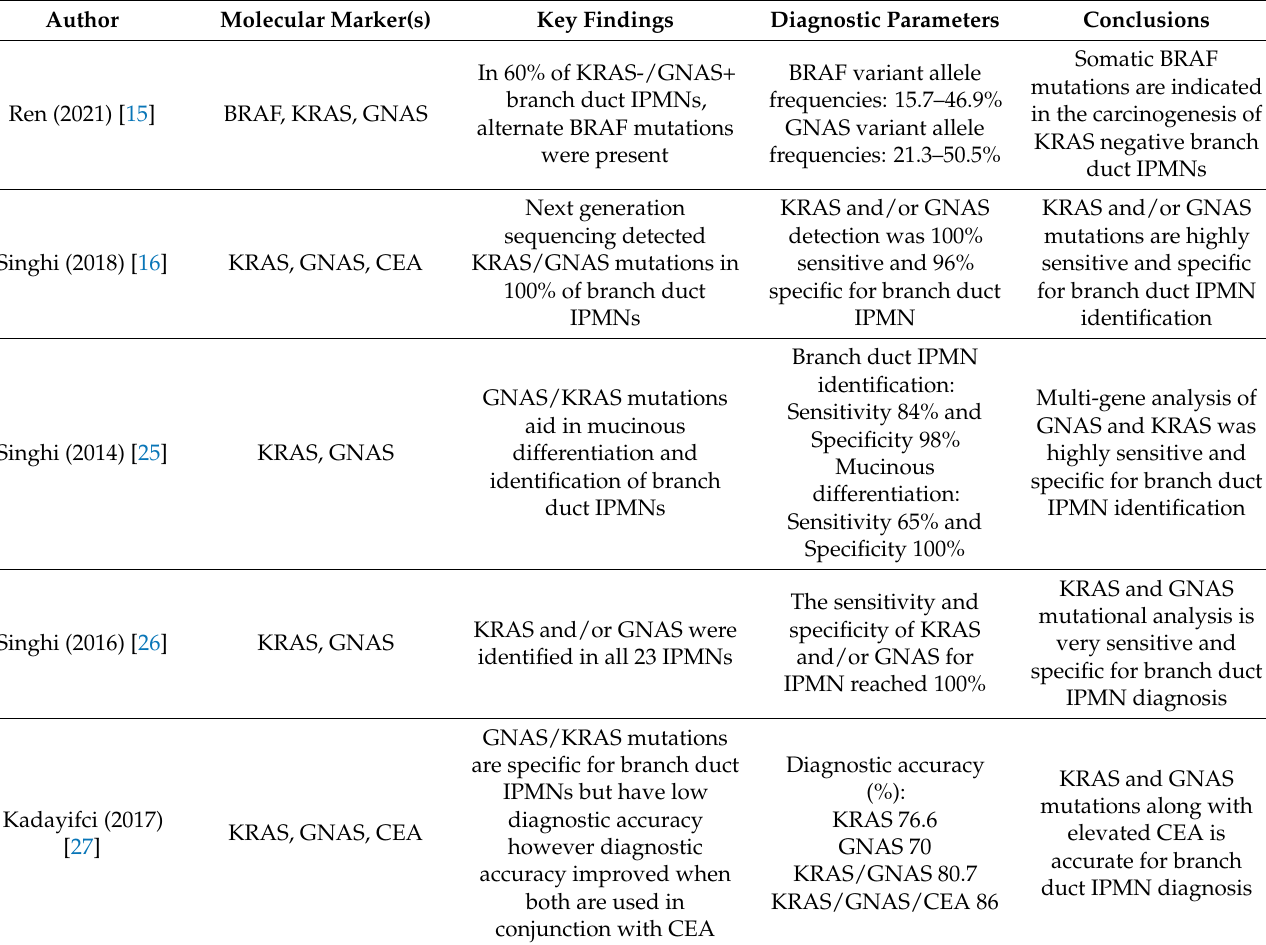
Table 1. Overview of studies investigating the diagnostic utility of KRAS and GNAS in branch duct